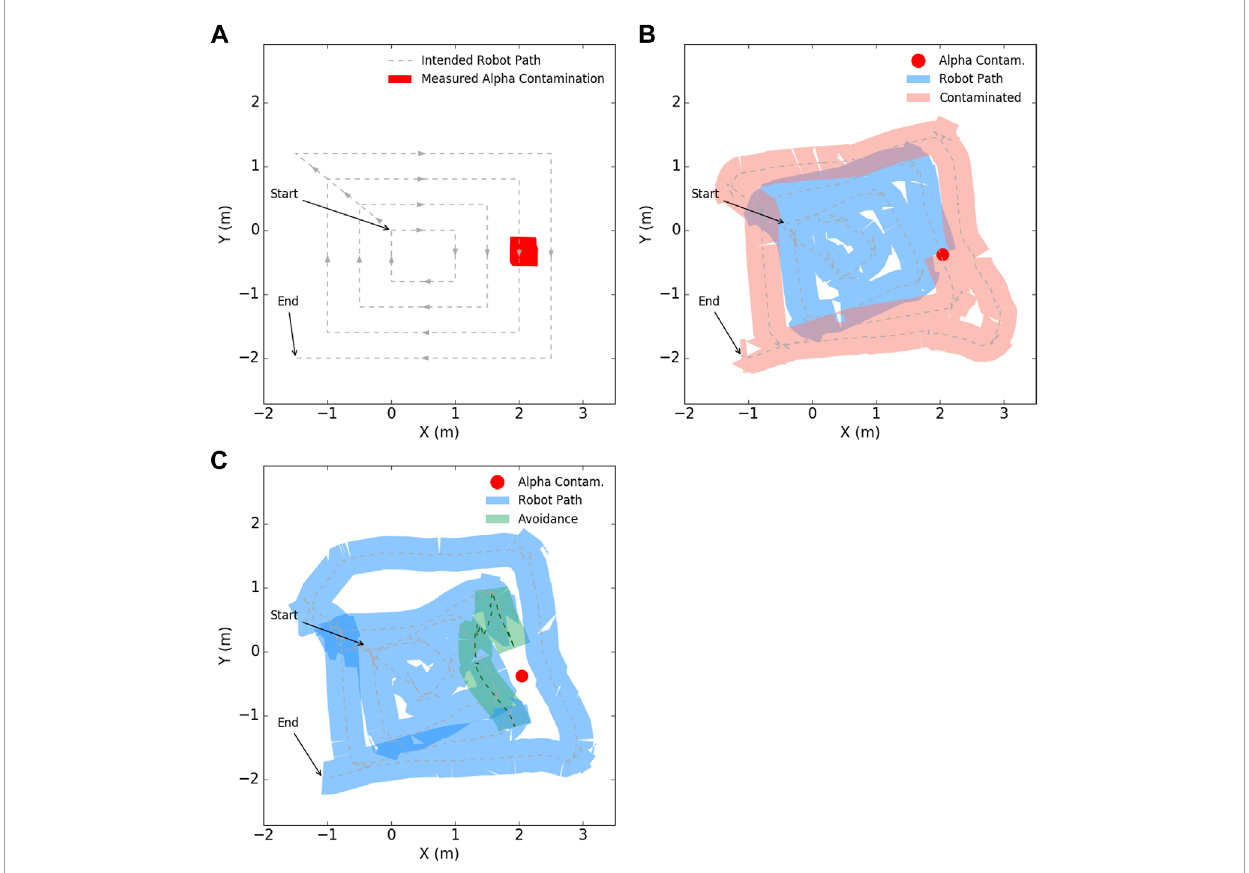
FIGURE 7 A four loop coverage path in the presence of measurable alpha contamination. (A) shows the generated path of the robot with estimated location of alpha contamination, (B) shows the actual path of the robot with possible spread of mobile contamination, with the width of the robot chassis indicated by the thickness of the path, (C) shows the robot reversing and maneuvering around the observed contamination due to the state machine logic in this